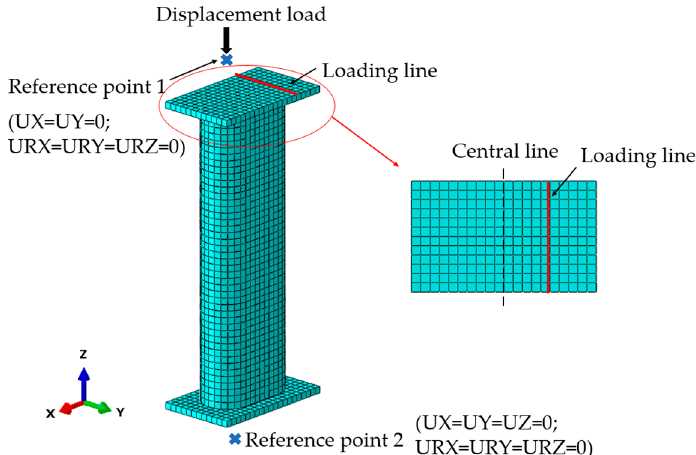
Figure 4. Finite element model.